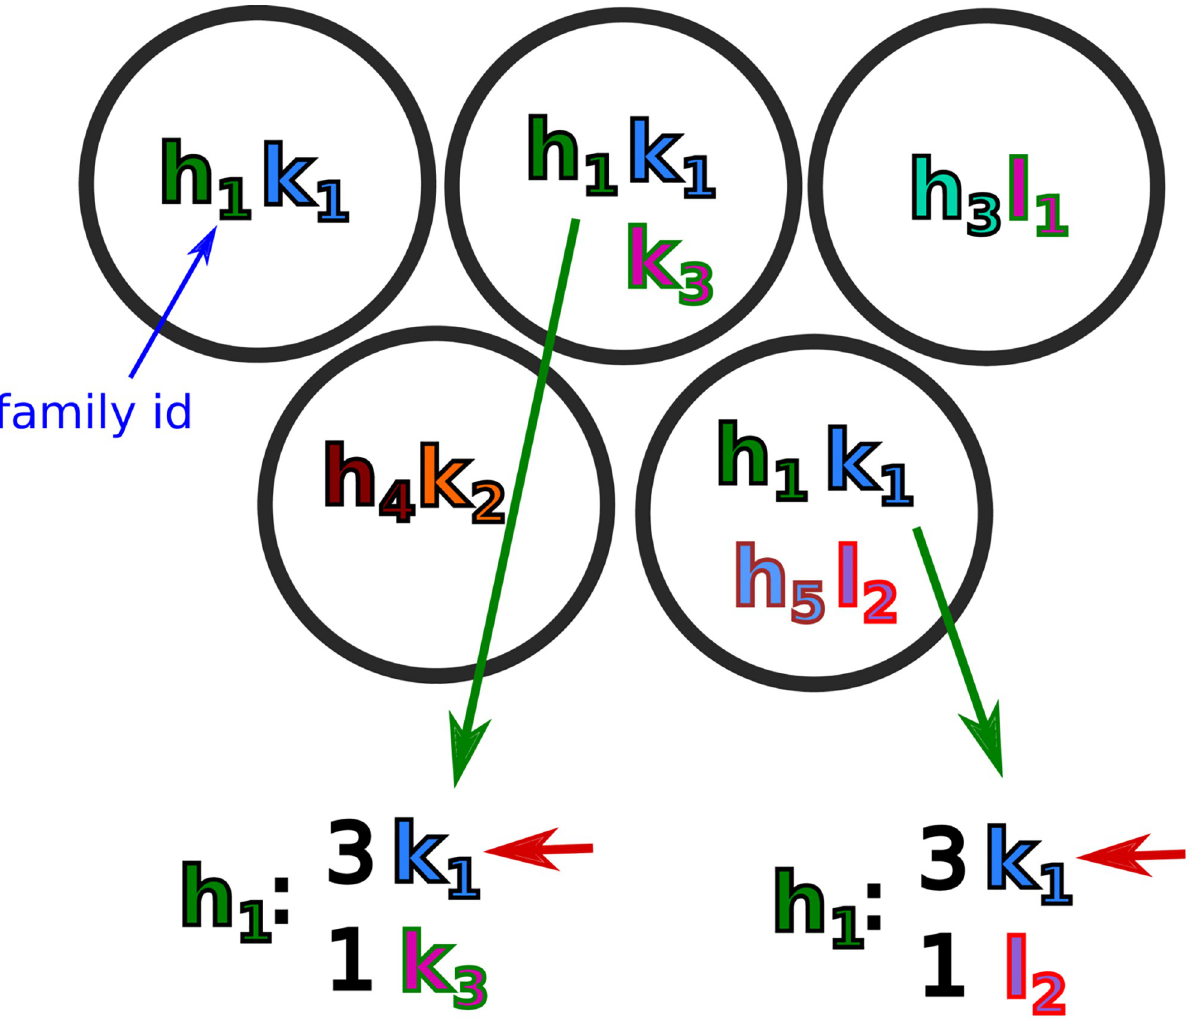
Fig 11. Schematic representation of the pair info cleaning algorithm showing five droplets, each with some combination of IgH, IgK, and IgL sequences, with subscripts (and color combinations) indicating clonal families (true clonal family id is also indicated as a subscript). The top left, top right, and bottom left droplets have unique pairings, so require no action. The top middle and bottom right droplets, on the other hand, require disambiguation. In the top middle droplet, h 1 has two potential light chain partners: k 1 and k 3 . Since k 1 has three h 1 family members paired with it across all the droplets, while k 3 has only one, we choose k 1 (red arrow). A similar procedure is then followed for the bottom right